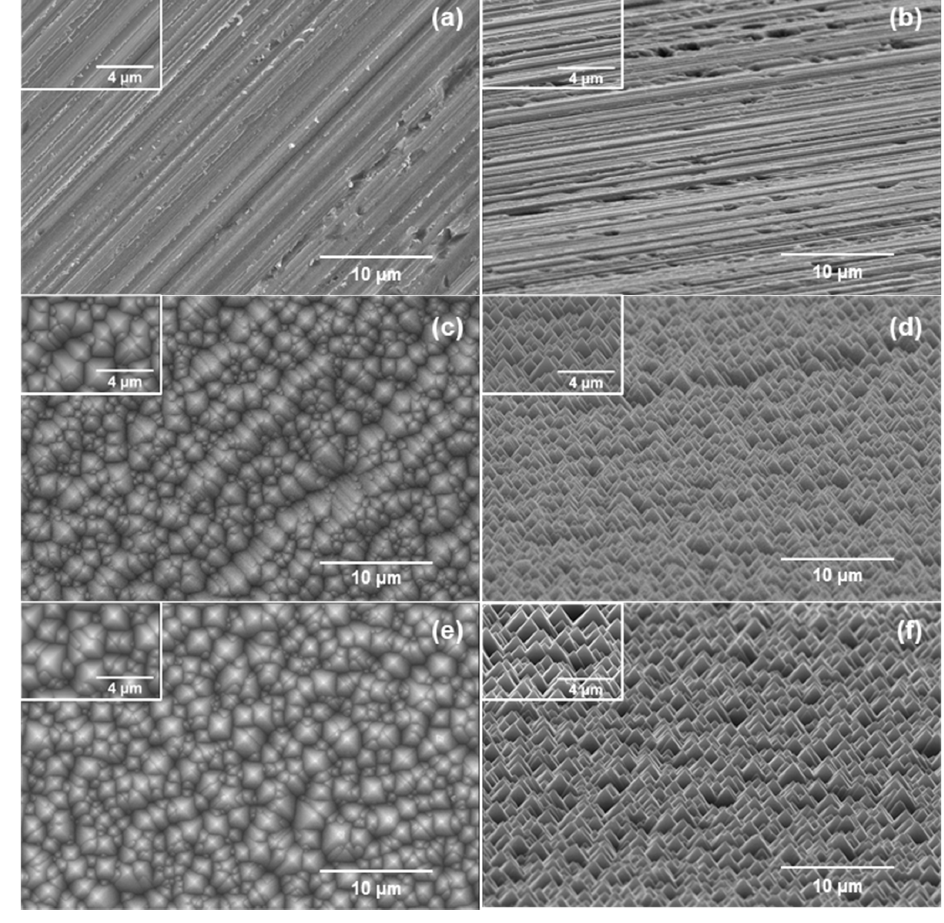
Figure 3. Scanning electron microscopy (SEM) images of surfaces of DWS as-cut mono-Si wafers subjected to anisotropic texturing with or without TT: ( a , b ) as-cut samples; ( c , d ) samples textured without TT; ( e , f ) samples textured after TT. Images ( a , c , e ) offer top views. Images ( b , d , f ) present tilted